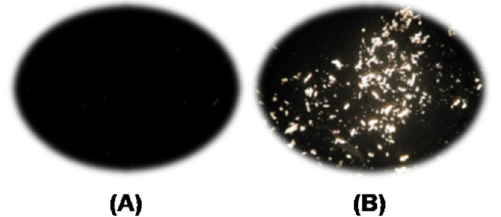
Figure 4. View of MCC dissolution using a polarized-light microscope: ( A ) complete and ( B ) partial cellulose dissolution.